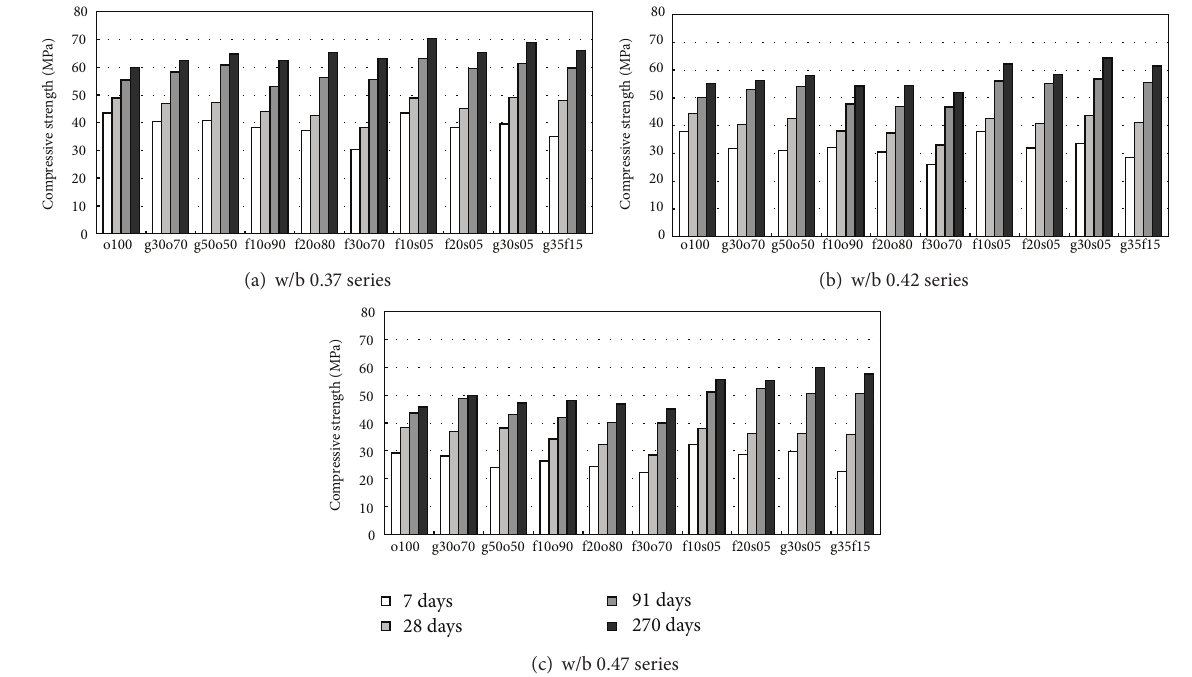
Figure 3: Strength development with admixtures and curing